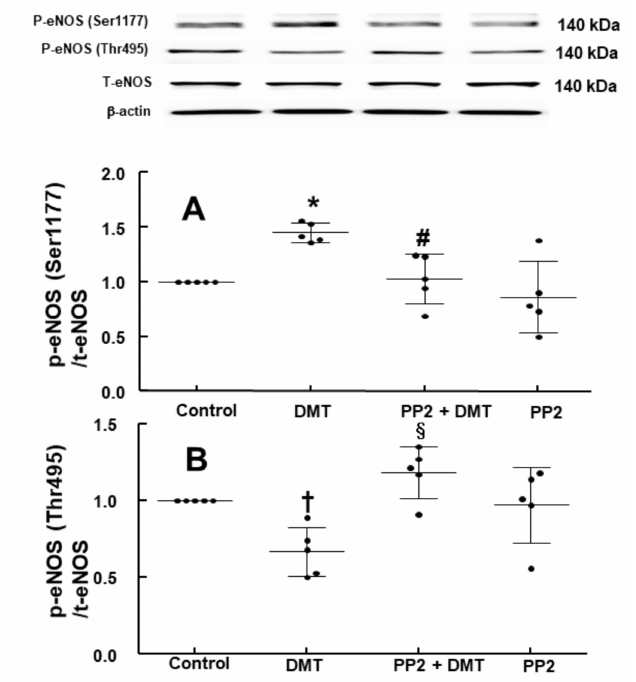
Figure 8. Effect of PP2 on dexmedetomidine (DMT)-induced stimulatory and inhibitory endothelial nitric oxide synthase (eNOS, Ser1177 ( A ) and Thr495 ( B )) phosphorylation in human umbilical vein endothelial cells (HUVECs). HUVECs were treated with DMT (10 − 6 M) alone for 5 min and with PP2 (2 × 10 − 5 M) for 30 min, followed by treatment with DMT (10 − 6 M) for 5 min or PP2 (2 × 10 − 5 M) alone for 35 min. Data (( A ): n = 5; ( B ): n = 4) are shown as mean ± standard deviation. n indicates the number of independent experiments. † p < 0.05 and * p < 0.01 versus control. # p < 0.05 and